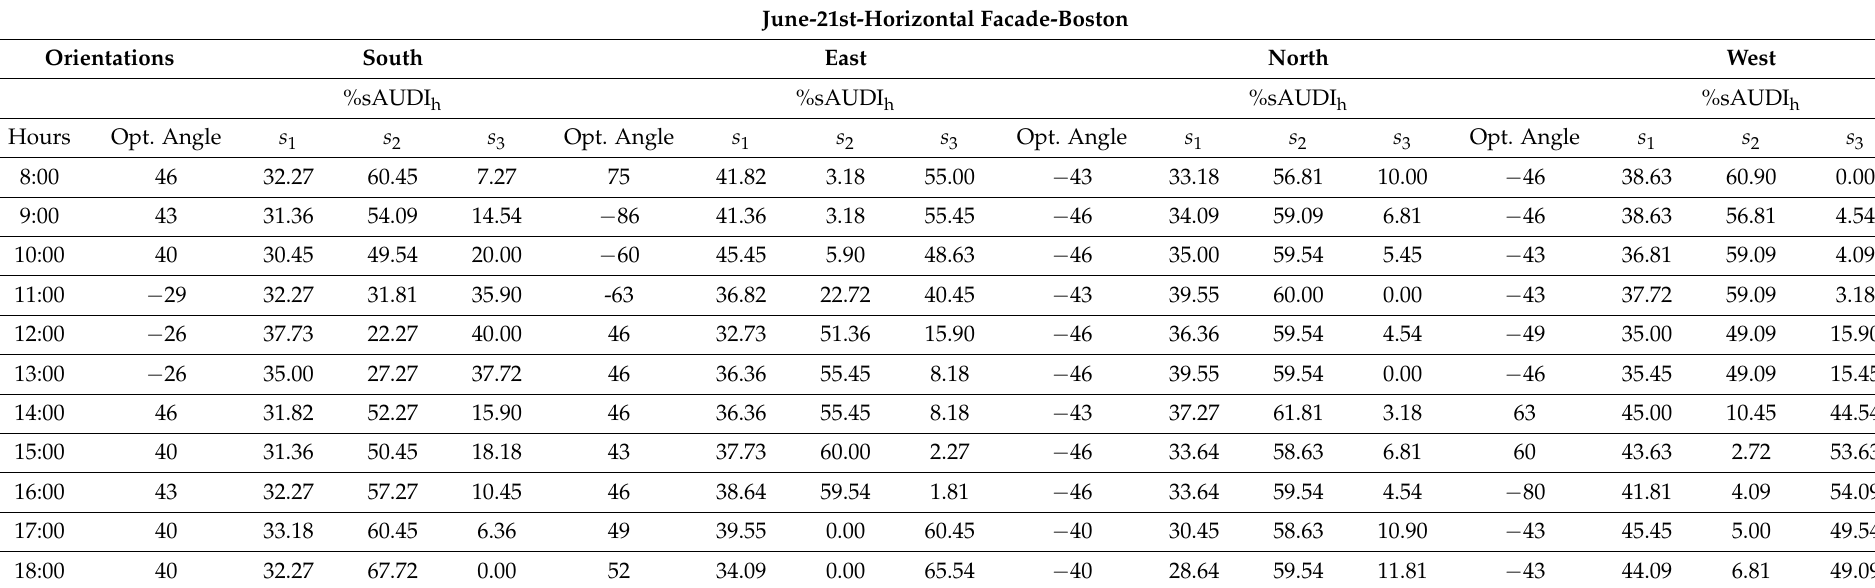
Table 8. The hourly optimum angles and their associated %sAUDI h on 21 June in Boston-Horizontal